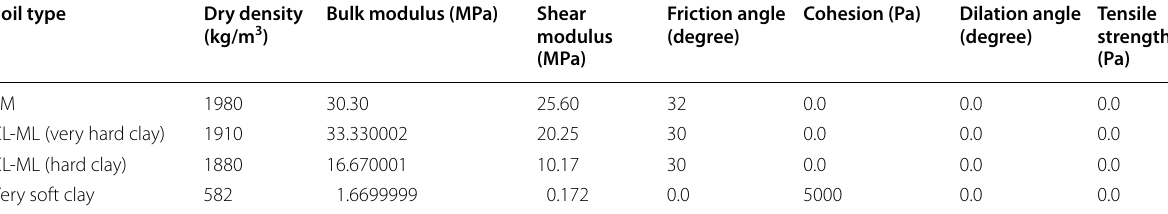
Table 10 The characteristics of the different substructure soil layers.